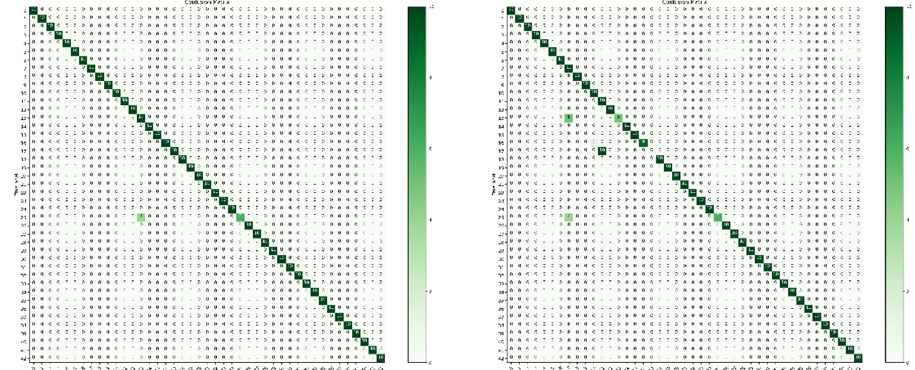
Figure 18. Comparison of the two confusion matrices in the case of missing parameters.